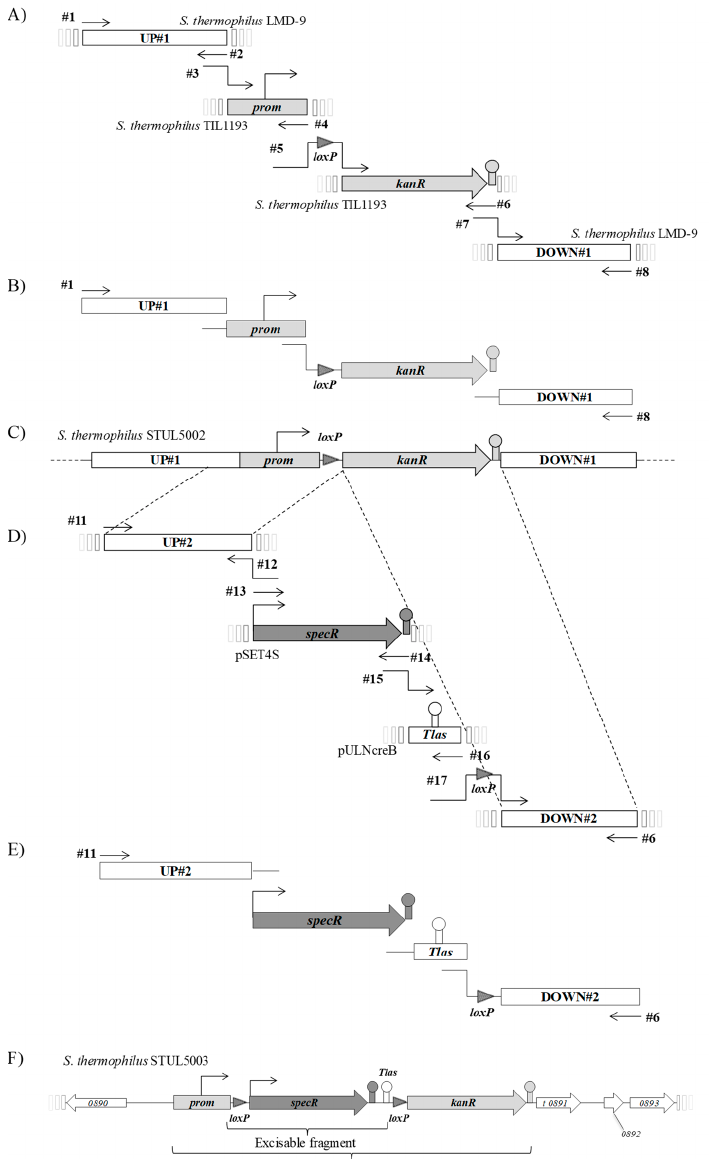
Figure 1. Construction of the chromosomal R-IVET cassette. The R-IVET chromosomal construction was cloned into the locus STER 0891 ( t0891 ) of S. thermophilus LMD-9 resulting in strain STUL5003. This strain was constructed in two steps. The first step (1A to 1C) corresponds to the construction of STUL5002 mutant: PCR amplification of individual fragments ( A ), overlapping PCR ( B ), and resulting construction on the chromosome of STUL5002 mutant ( C ). The second step (1D to 1F) illustrates the construction of STUL5003 mutant: PCR amplification of individual fragments ( D ), overlapping PCR ( E ), and resulting chromosomal construction of STUL5003 mutant ( F ). Numerical values indicated in italics in genes ( F ) correspond to locus tags as described in the annotated sequence of LMD-9 chromosome (NC_008532_1). Oligonucleoti0des used as amplification primers are indicated as black arrows and are labeled with their # numbers (see Table S1, Supplementary Materials). UP and DOWN regions correspond to upstream and downstream sequences flanking the fragments to be cloned, respectively. The specR, kanR , and prom fragments correspond to genes encoding a spectinomycin adenyltransferase conferring resistance to spectinomycin and streptomycin, a 3 (cid:48) 5”-aminoglycoside phosphotransferase of type III conferring resistance to kanamycin, and the promoter region of kanR gene, respectively. The gray triangle corresponds to the loxP sequence that is recognized by the specific site recombinase